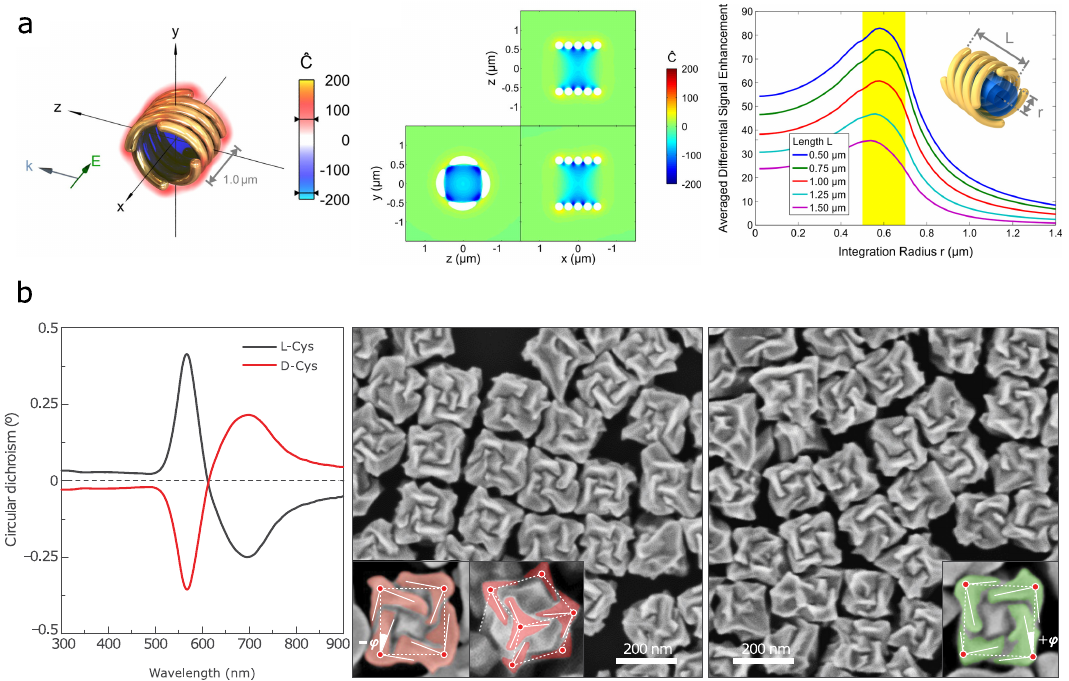
Figure 4. 3D chiral plasmonic nanostructures: ( a ) simulated four-helix gold nanostructure showing strongly confined optical chirality within the helices (left, middle) and the graph presenting the enhancement of differential absorption signal depending on the radius of integration, for different length of a structure (right). Adapted with permission from Schaferling et al. [76] Copyright 2014 American Chemical Society. ( b ) Three-dimensional plasmonic helicoids controlled by cysteine chirality transfer: CD spectra and SEM images of chiral nanoparticles synthesized using L-Cys and D-Cys. The insets highlight the tilted edges (solid lines), cubic outline (dashed lines) and tilt angles ( − φ and + φ ). Reproduced with permission from Lee et al. [77] Copyright 2018 Springer